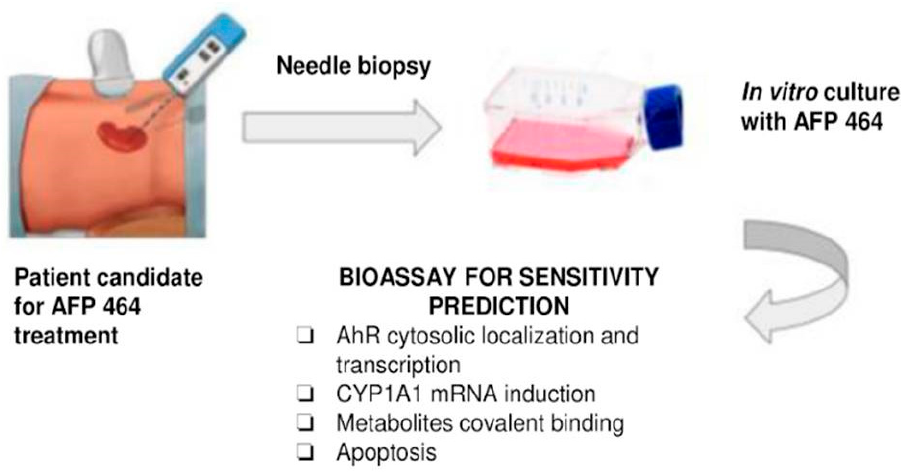
Figure 4. Proposed procedure for identification of patients whose renal tumors may be responsive to AFP 464 treatment (data reported in [33] and [39]). AFP 464 treatment (data reported in